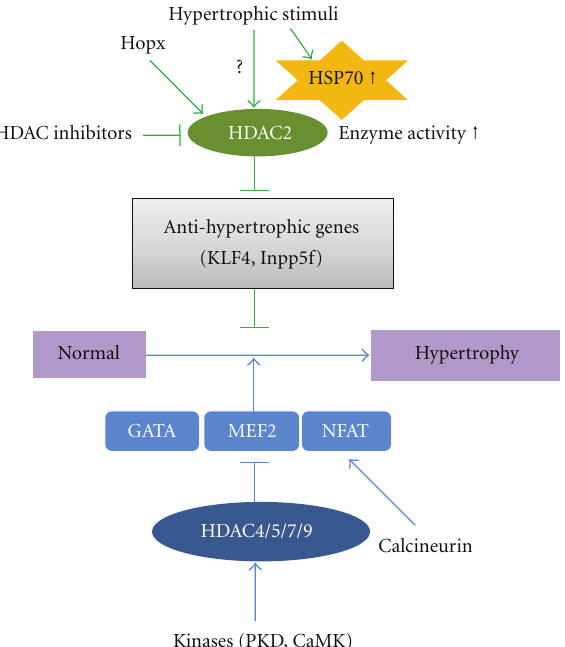
Figure 1: The signaling cascade of class I and IIa HDACs in the development of cardiac hypertrophy. Class I HDACs can be regulated by the Hopx/HDAC2/HSP70/KLF4 pathway. Cardiac hypertrophy is induced in Hopx transgenic mice through the recruitment of HDAC2. Hypertrophic stresses including pressure overload or agonist-induced HSP70 expression are followed by its association with HDAC2. The resultant increase in HDAC2 activity decreases the expression of anti-hypertrophic mediators including KLF4 and Inpp5f. This diagram is adapted from the works of Kook et al. [20] and Kee et al. [32, 38] (JCI, 2003; Circulation Research, 2008; JMCC, 2009). Class II HDACs can be activated by PKD or CaMK. They interact with MEF2. MEF2 also associates with GATA4 and NFAT transcription factor. NFAT can be triggered by calcineurin. Class IIa HDACs can repress cardiac hypertrophy through MEF2 either directly or